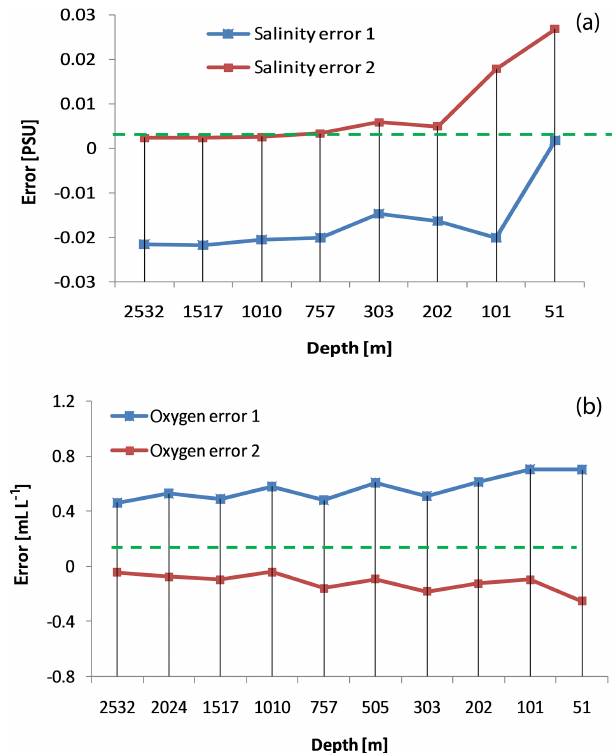
Figure 3. The salinity (a) and DO (b) errors between what was measured by the sensor on the probe and what was measured on board from water samples for the two conductivity and oxygen sen- sors, 1 and 2, along a vertical profile in a deep